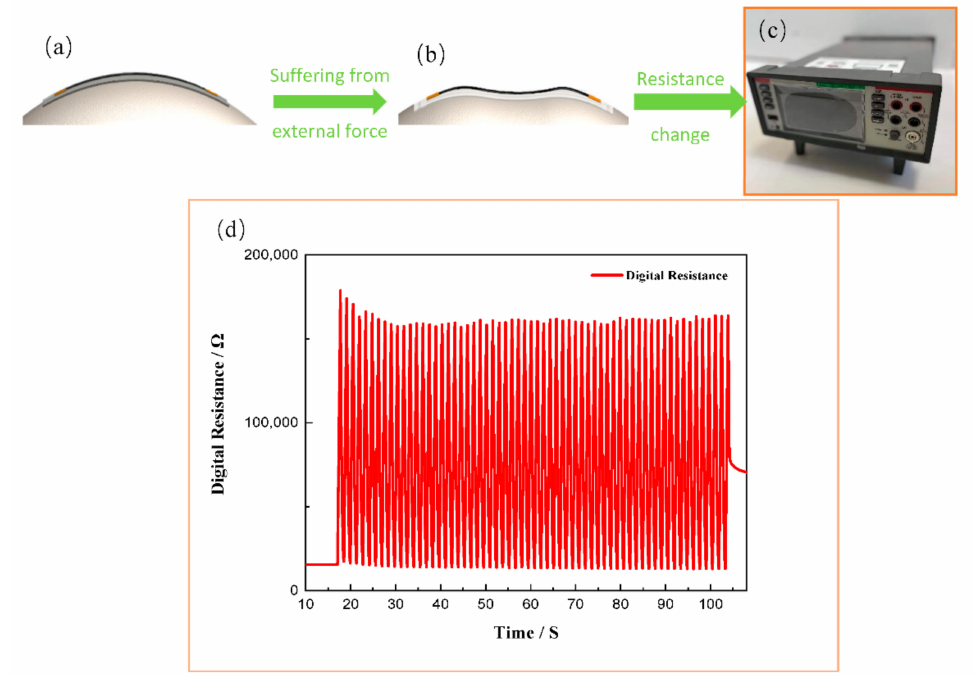
Figure 9. The feedback principle of the smart boxing glove: ( a ) before receiving an external force; ( b ) after receiving an external force. ( c ) Desktop multimeter. ( d ) Change in the resistance over time.